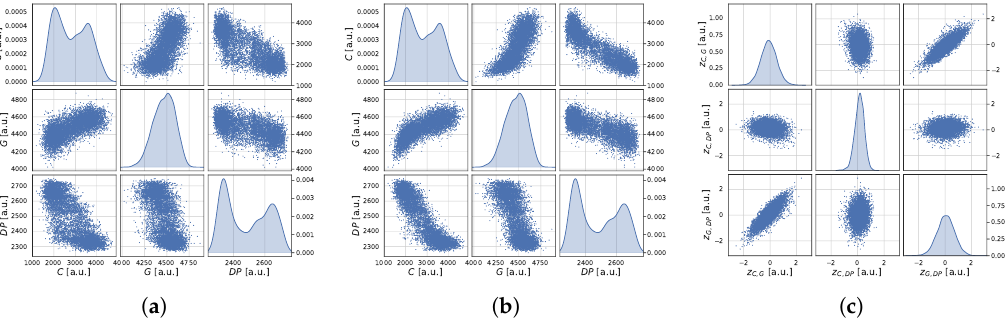
Figure 6. Real data: physics dynamics and meter behavior decoupling of signals shown in Figure 5. ( a ) Scatter plot of the signals. They can draw very different patterns depending on their value, misalignment and correlation. ( b ) Signal alignment. It always improves the correlation between the signals. ( c ) Data after the process filtering. The measured dynamics is filtered and only the instrumentation behavior is